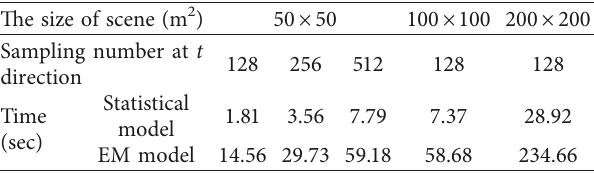
Figure 8: Comparisons of PDF of 3D sea clutter between statistical and EM models. Table 2: Comparison of the consumed time in the simulations of 3D sea clutter with different sizes of scenes and sampling number at t